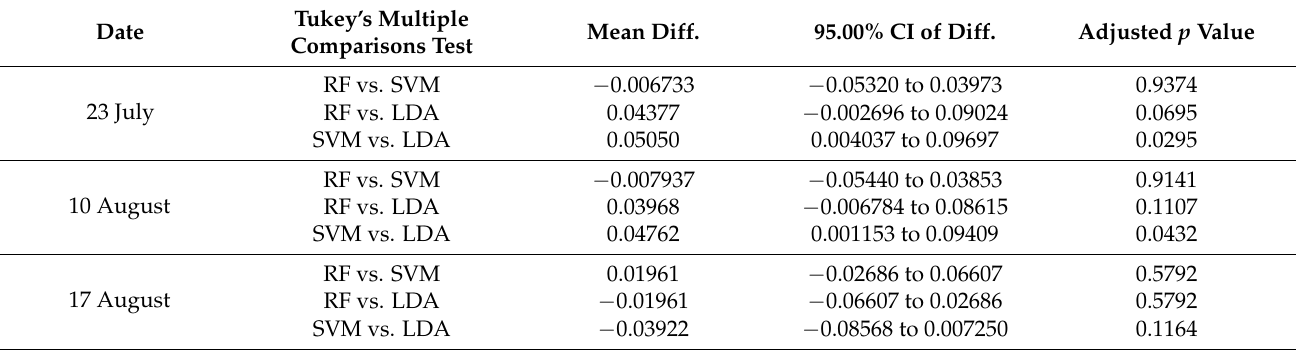
Table 3. The difference comparison results of the accuracy of the three algorithms under each